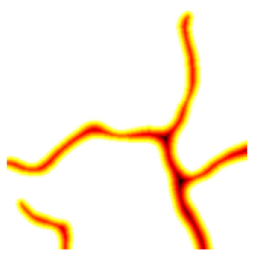
Figure 11. Maximum width visualization.